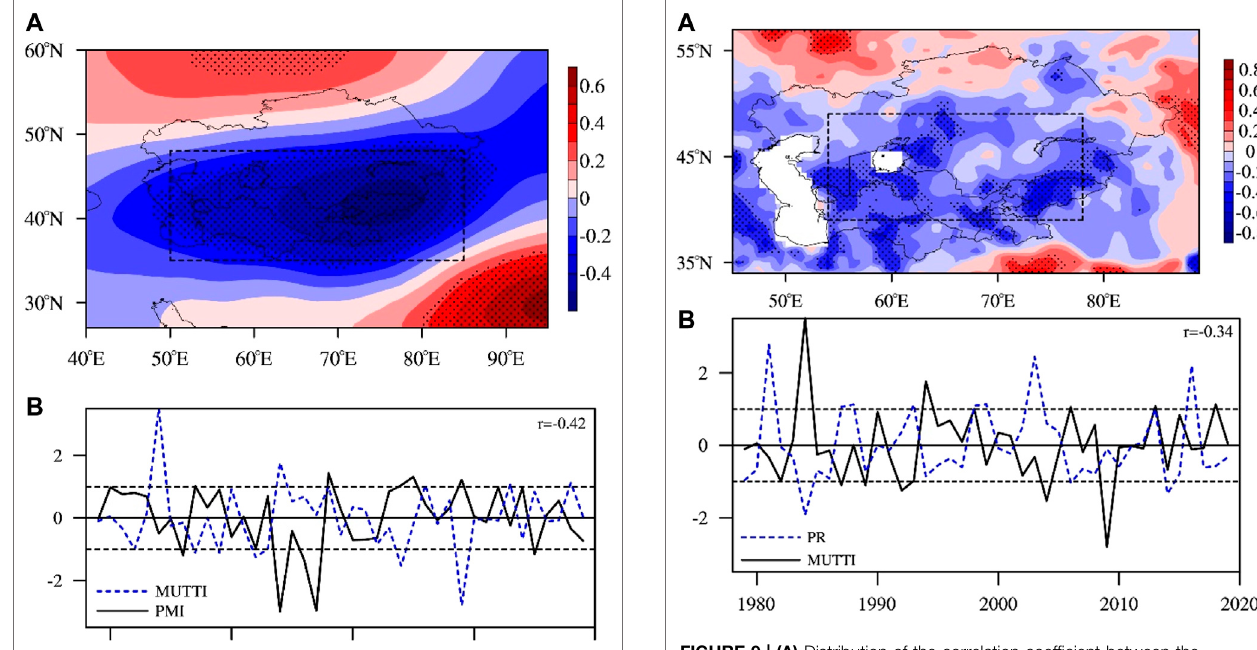
FIGURE 9 | (A) Distribution of the correlation coef fi cient between the MUTTIandsummerprecipitationinCentralAsia. (B) TimeseriesofMUTTIand summer precipitation in Central Asia. The rectangular lines in (A) indicate the regions selected for the calculation of regional precipitation, and the dotted area in (A) shows the area that passed the 90% con fi dence level student ’ s